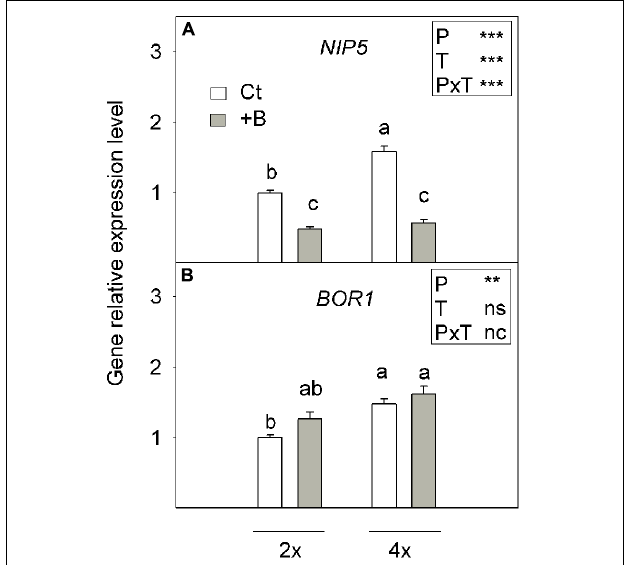
FIGURE 3 | Relative gene expression level of (A) NIP5 and (B) BOR1 genes measured by qRT-PCR analysis in roots of the 2x and 4x CC seedlings grown in vitro (Experiment 1) for 45 days in nutrient media supplemented with 50 µ M (Ct) or 400 µ M ( + B) H 3 BO 3 . Values are the means ± SE of nine plants ( n = 9). Ploidy (P) and treatment (T) effects tested by two-way ANOVA are indicated as follows: ∗∗ P < 0.01; ∗∗∗ P < 0.001; ns, not significant; nc, not considered. Different letters indicate significant differences at P < 0.05 using Duncan’s multiple range test.